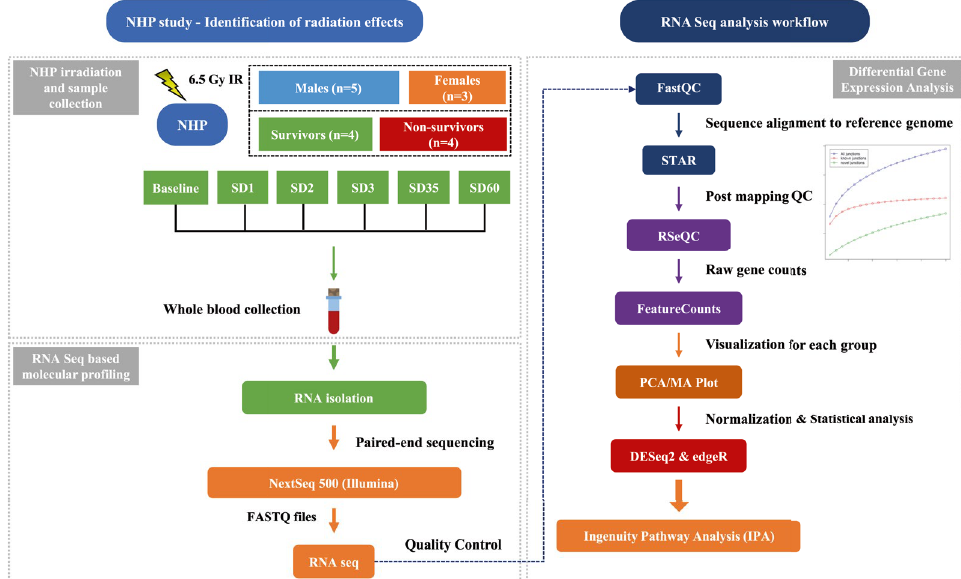
Figure 1. Experimental and data analysis workflow. Longitudinally collected blood samples including: C (pre-irradiation), SD1 (day 1 post-irradiation), SD2 (day 2), SD3 (day 3), SD35 (day 35), SD60 (day 60) were collected from 7 NHPs for NextSeq 500 paired-end sequencing analyses and downstream bioinformatics analyses. Differential gene expression and functional pathway analysis were performed for gaining insight into radiation response in the survivors and non-survivors. Figure is created by the author using Microsoft PowerPoint (https:// www. micro soft. com/ en- us/ micro soft- 365/ power